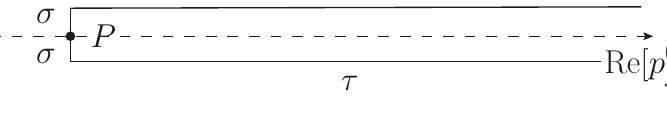
Figure 16 . Domain